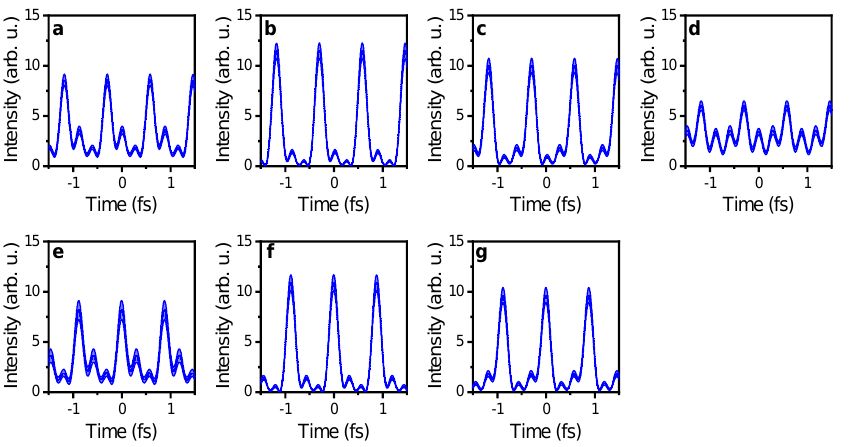
Figure 8. Reconstructed attosecond pulses for a phase scan using the phase shifter PS 3 . (a – g ) Evolution of the intensity profile of the attosecond pulses in the attosecond pulse train generated with the harmonic comb containing the harmonics H 7 , H 8 , H 9 , and H 10 of the seed laser, for different values of the phase shifter(PS 3 ), corresponding to Figure 7a,h(a), Figure 7b,i(b), Figure 7c,j(c), Figure 7d,k(d), Figure 7e,l(e), Figure 7f,m(f), and Figure 7g,n(g). The error in the reconstruction is indicated as a shaded region in each